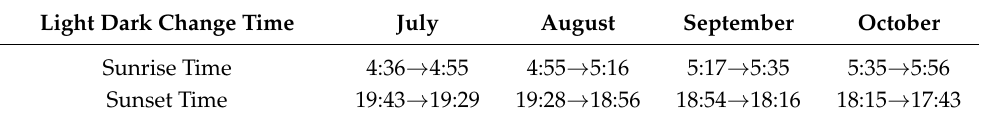
Table 2. Variation of sunrise and sunset time in Dangtu county from July to October in 2021. Light Dark Change